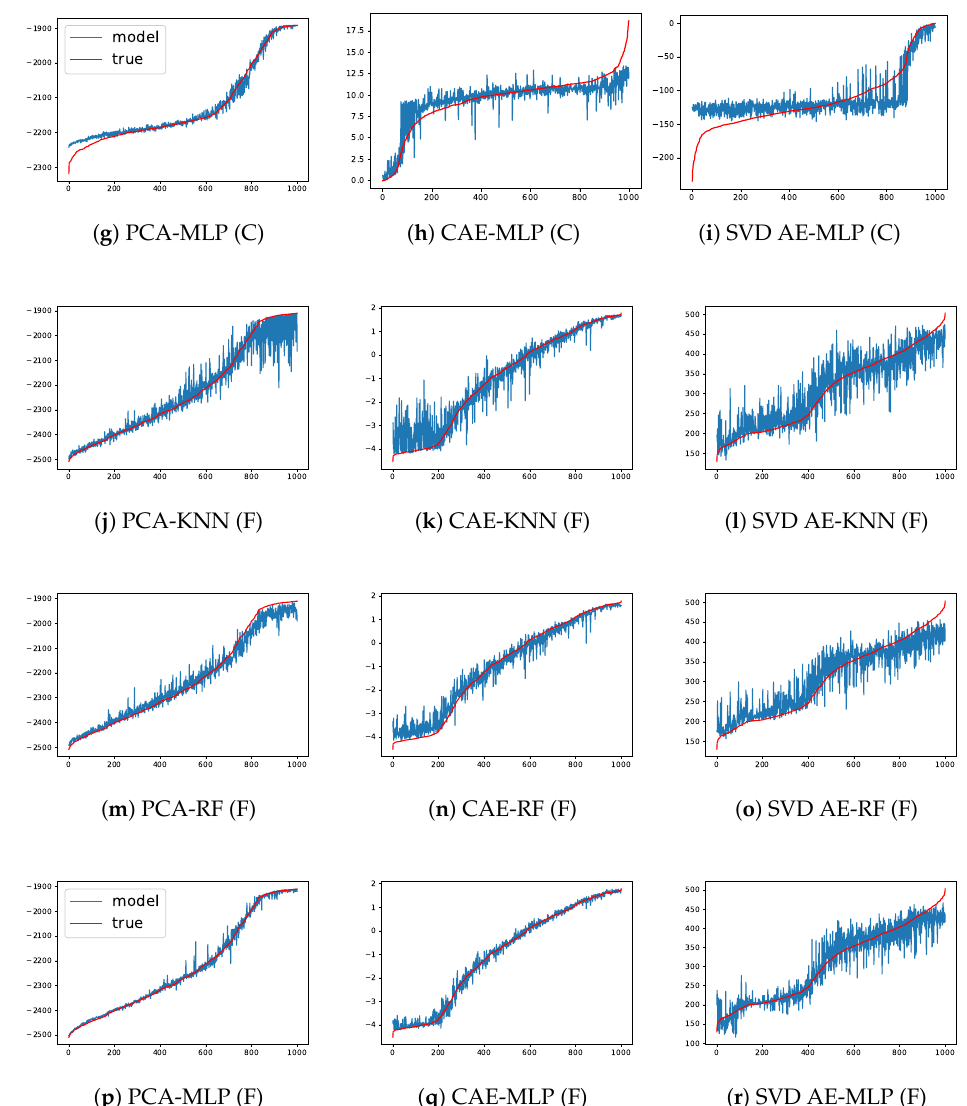
Figure 8. Prediction results of latent variables (with the highest variance in each case) for q = 30 in the test dataset for both Chimney (C) and Ferguson (F) wildfires at day 4. The x-axis represents reordered samples according to their true latent